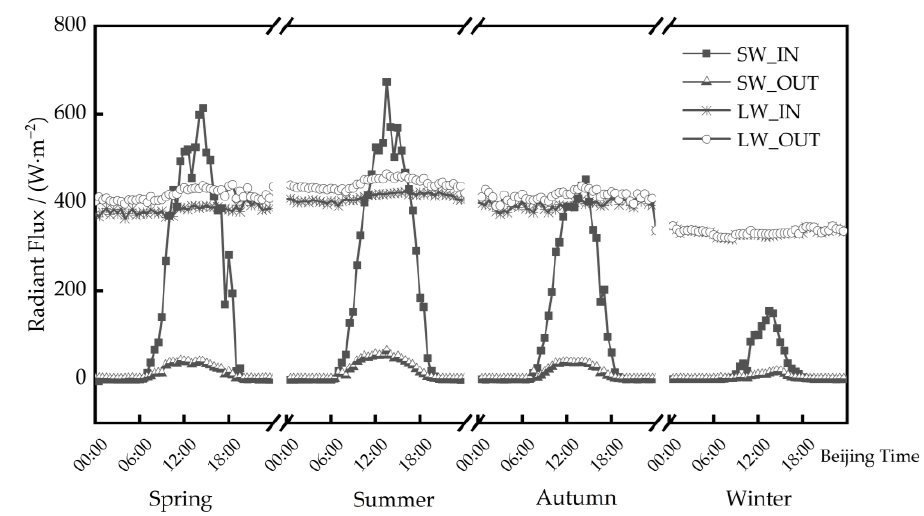
Figure 7. Seasonal average daily variation of each component of surface radiation balance.